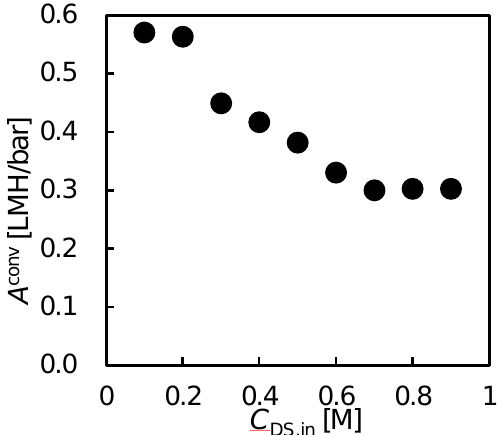
Figure 6. Converted water permeability as a function of applied hydraulic pressure at various DS concentrations ( C DS ). PRO conditions: FS, tap water; Q DS,in : 4.0 L/min; Q FS,in ; 1.5 L/min.